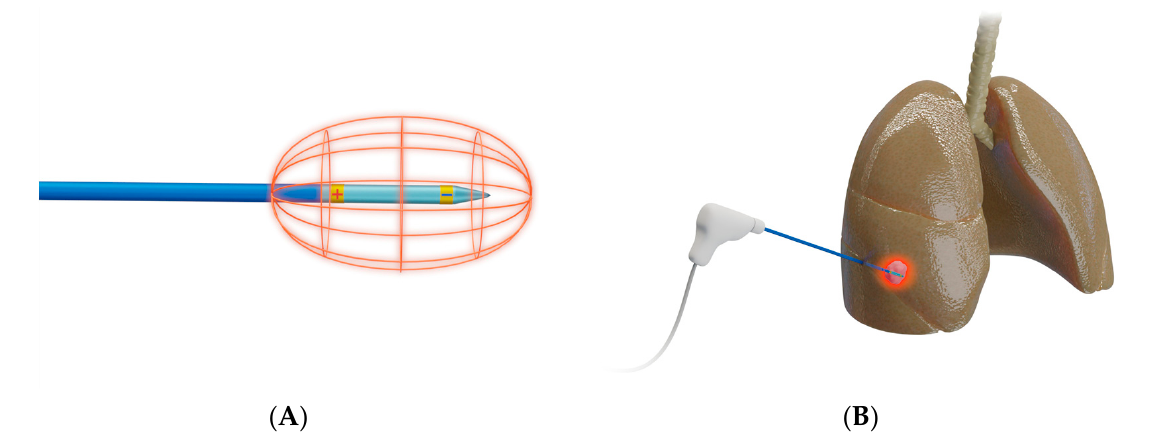
Figure 2. Schematic presentation of radiofrequency ablation . ( A ) Design of a bipolar RFA system, in which electrical current is delivered through an electrode that functions as both anode and cathode [26]; bi-polar electrodes obviate the need for grounding pads; ( B ) Representative example of RFA used to target a lesion in right middle lobe of a lung.